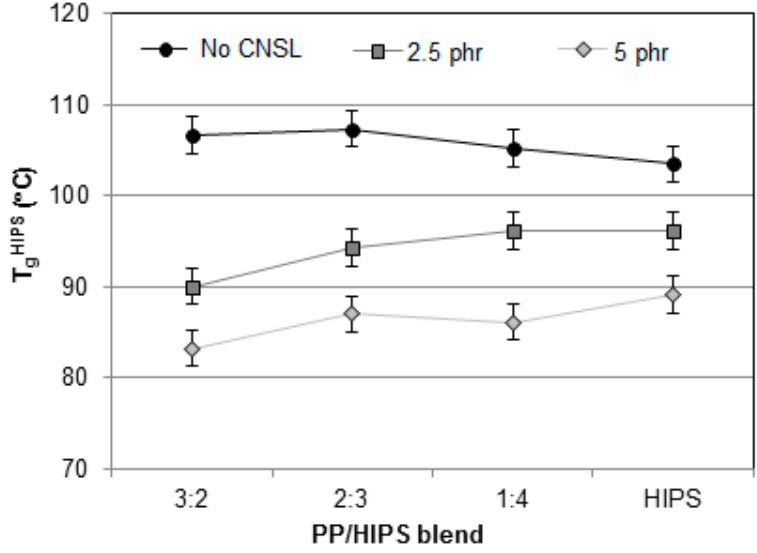
Figure 15. Tg values for HIPS and the 3:2, 2:3 and 1:4 PP / HIPS blends with 0, 2.5 and 5 phr of CNSL.